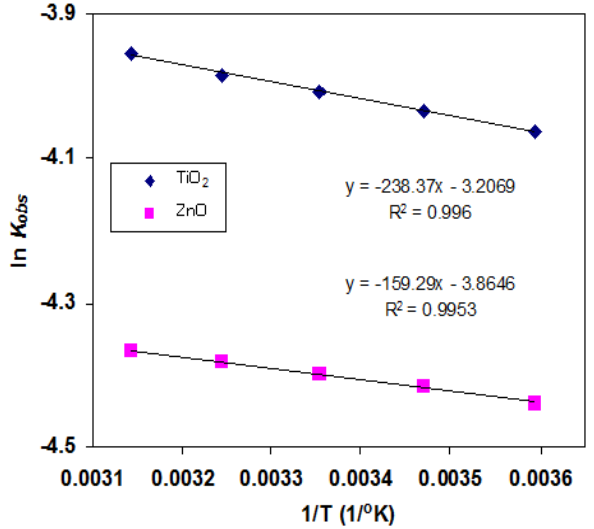
Figure 6. Plot of ln( k obs ) versus 1/T for the decolorization and mineralization of FB1 by the HPO process ([FB1] 0 = 50 mg/L, [TiO 2 ] = 0.8 g/L, [ZnO] = 1.2 g/L, and pH = 6.7).